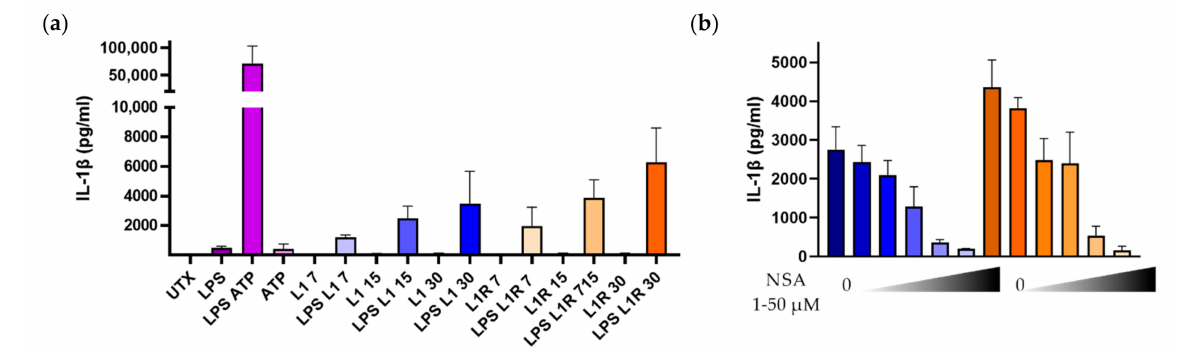
Figure 6. Inflammasome activation in GMDCs treated with LPS and histidine-rich peptides. GMDCs were generated by culture with 20 ng/mL GM-CSF for 6 days. On day 6 ( a ), GMDCs were left untreated (UTX) or stimulated with 0.5 µ g/mL LPS for 3 h, followed by 1 h of incubation with 2 mM ATP, or with LAH4-L1 (L1) or LAH4-L1R (L1R) at various concentrations (7, 15, or 30 µ g/mL). The supernatant was harvested, stored at − 20 ◦ C, and analyzed via an ELISA for IL-1 β . After LPS stimulation, GMDCs were incubated with 0–50 µ M NSA before treatment with 15 µ g/mL HRPs for 1 h ( b ). ( n = 3), mean ±